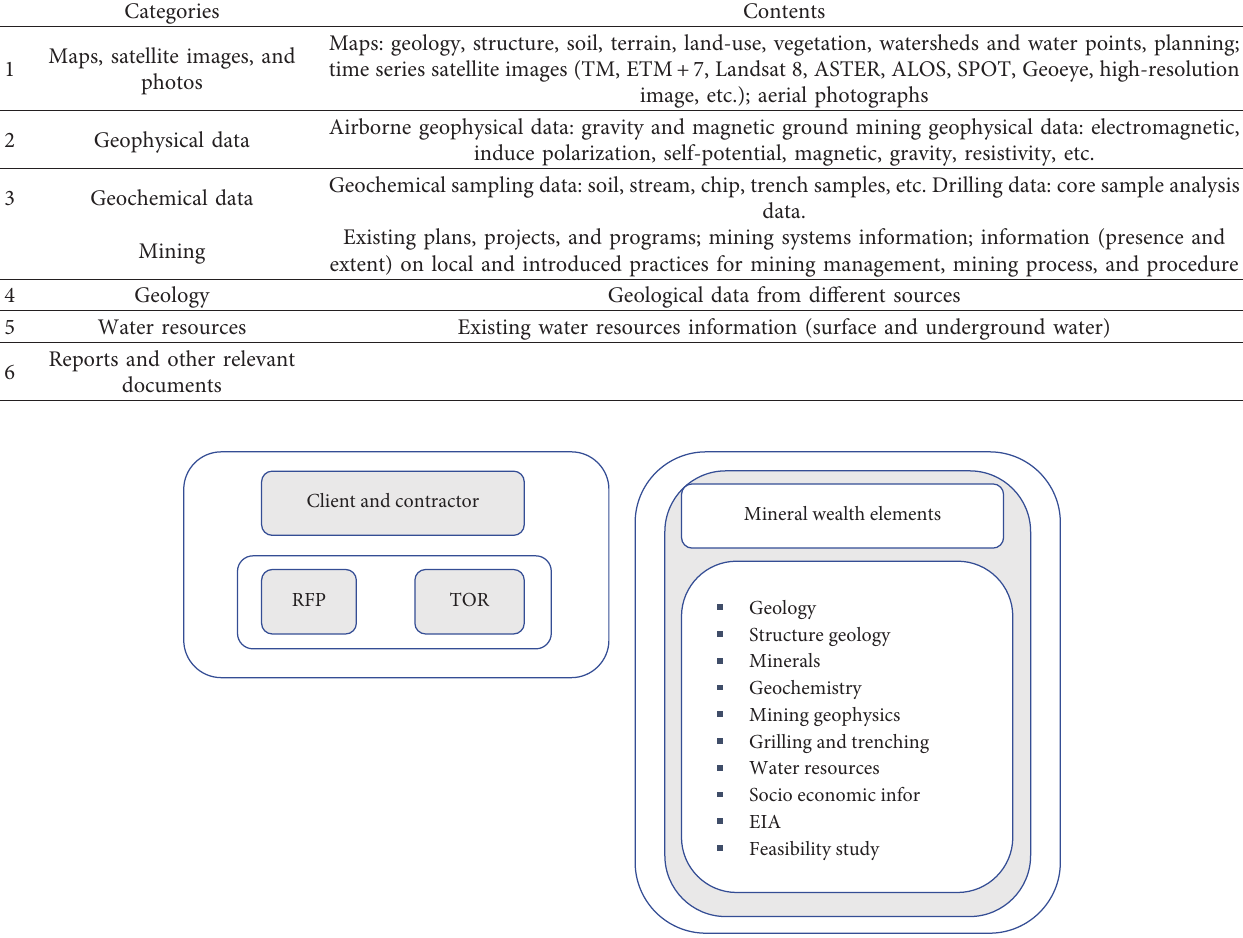
Table1: Geodatabase used to build the investment map of mineral